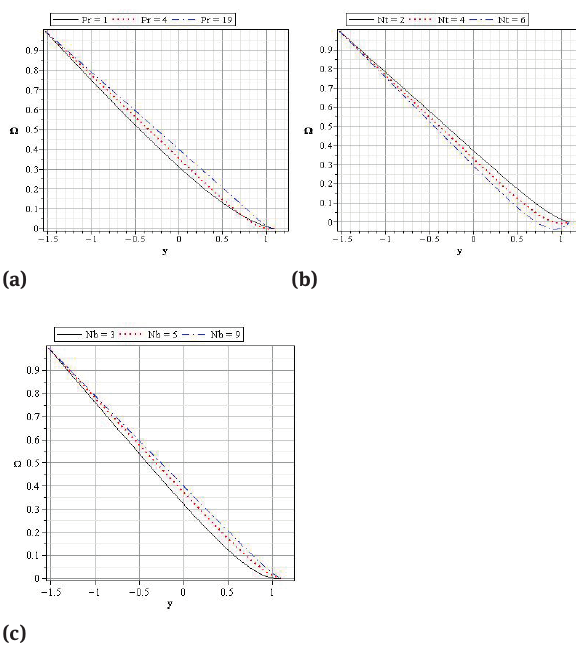
Fig. 4: Mass distribution Ω versus y for (a): x = 1, Gt = 0.5, Gc